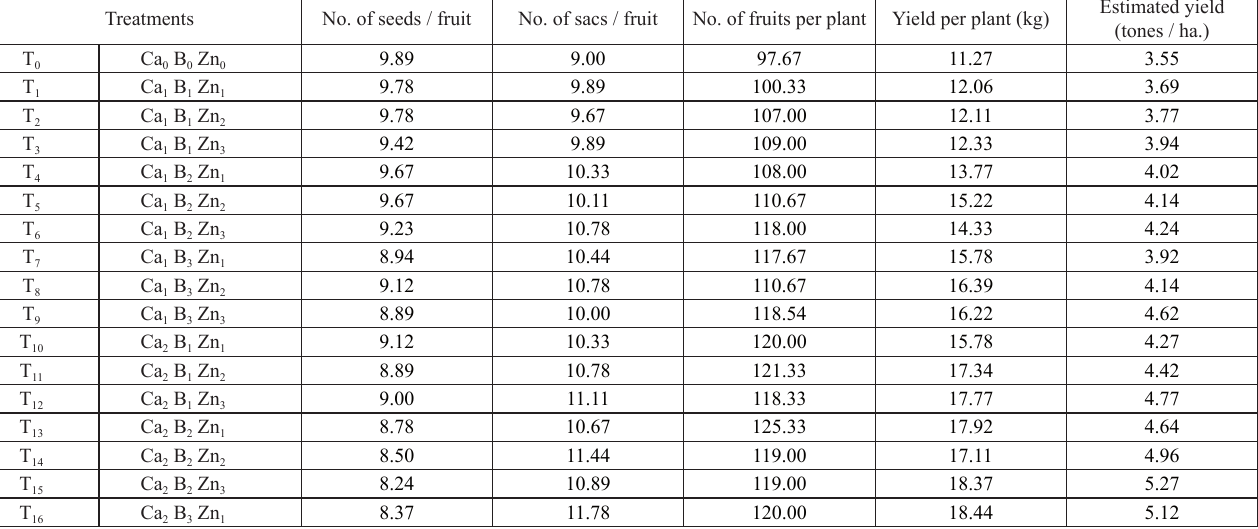
Table 2 Effect of pre-harvest spray of calcium nitrate, boric acid and zinc sulphate on physical and quality attributes of Nagpur mandarin Treatments